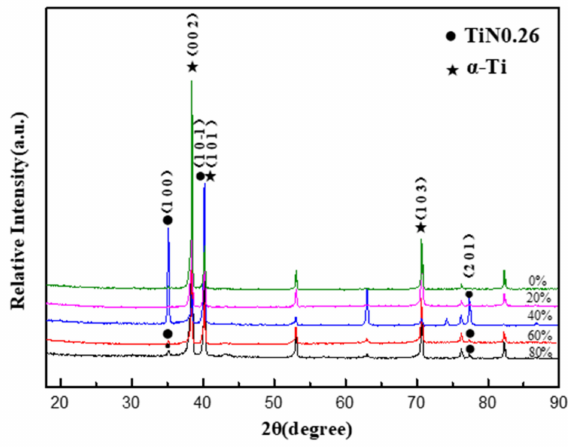
Figure 8. Surface XRD pattern of series of deformed alloy samples after nitriding at 450 ◦ C for 16 h. In Figure 9, the EDS point analysis of the chemical composition of the 0%, 20%, 40%, 60%, and 80% deformed samples after 450 ◦ C for 16 h nitriding treatment are listed. The point scanning positions are marked in each sub-picture, where spherical particulate matter exists. The element content in the scanning area is shown in Table 1. In Table 1, it indicates that with the increase of the deformation rate of TA2 samples, the mass percentage of N element first increases and then decreases, and the nitrogen-titanium atomic ratio also indicates, at first, an increasing and then decreasing trend. After the deformation rate exceeds 40%, the nitrogen atom content of the white spherical particulate matter decreases because the increase in defect density and the weakening of the interaction force between atoms accelerates the diffusion of active nitrogen atoms, and more N on the surface diffuses into the inside. The 60% sample has the highest surface nitrogen atom content of 76.07%, and the nitrogen-titanium atom ratio is about 3:1. In addition, the bigger the size of the white particles selected at special points is, the higher the N element content is.